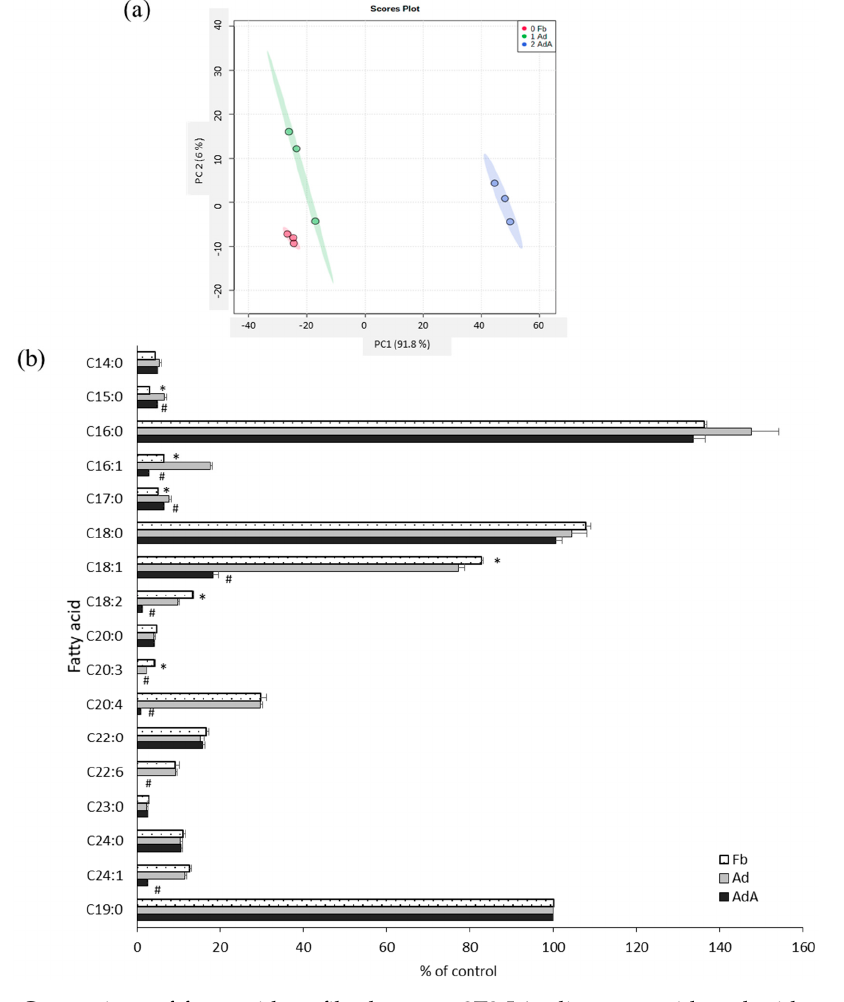
Figure 3. Comparison of fatty acid profiles between 3T3-L1 adipocytes with and without aspirin treatment. The fatty acids in the conditioned media of 3T3-L1 fibroblasts (Fb), adipocytes (Ad), and cells treated with aspirin during di ff erentiation (AdA) were collected and detected by GC-MS. ( a ) The PCA score plots of Fb, Ad, and AdA. ( b ) Fatty acids with significant di ff erences. Data are presented as mean ± SEM of three independent experiments. Statistical analysis was done by one-way ANOVA and the LSD post hoc test. Significant di ff erences are presented as * p < 0.05 between Fb vs. Ad and # p < 0.05 between Ad vs.